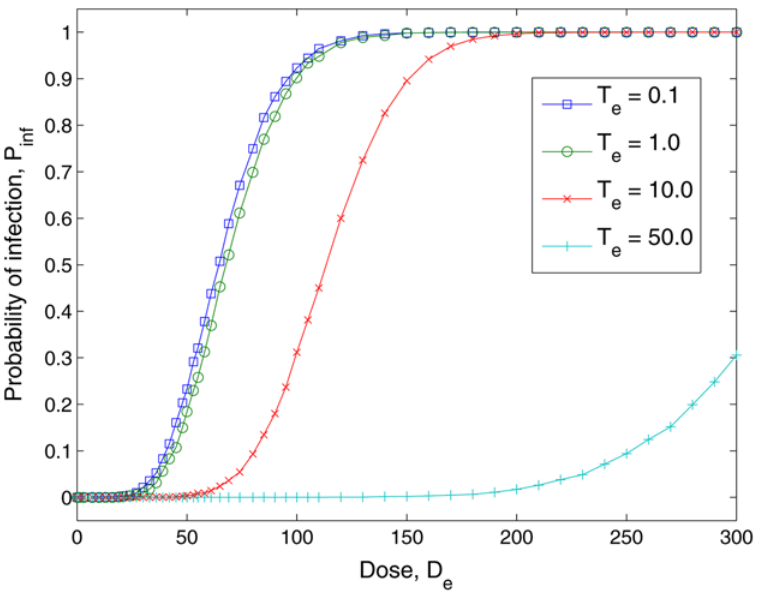
Figure 7. Predicted effects of varying exposure times ( T e ) when inoculated with Poliovirus type 1. Parameters are defined as stated in Figure 4.